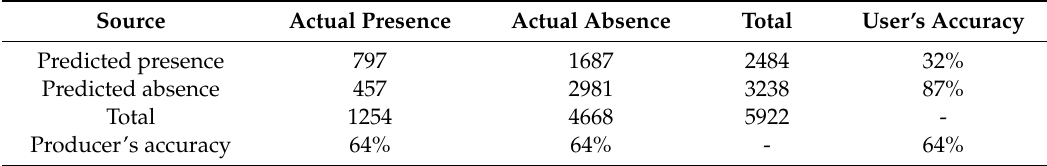
Table 5. Confusion matrix to assess accuracy of ash presence / absence for Forest Inventory and Analysis plots in Minnesota, USA.